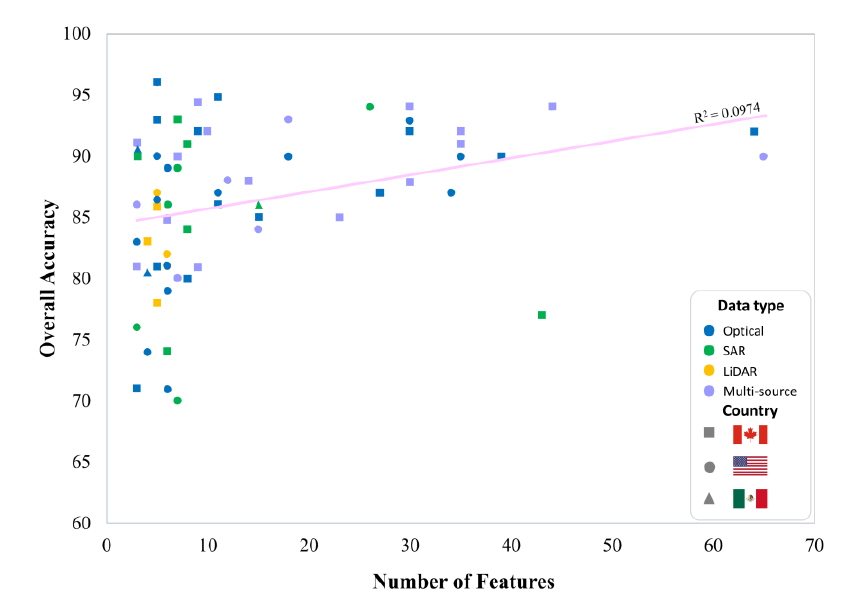
Figure 17. Correlation of overall accuracy and number of features.